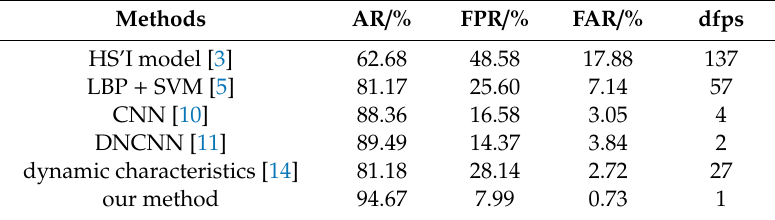
Table 5. Comparisons with different methods.